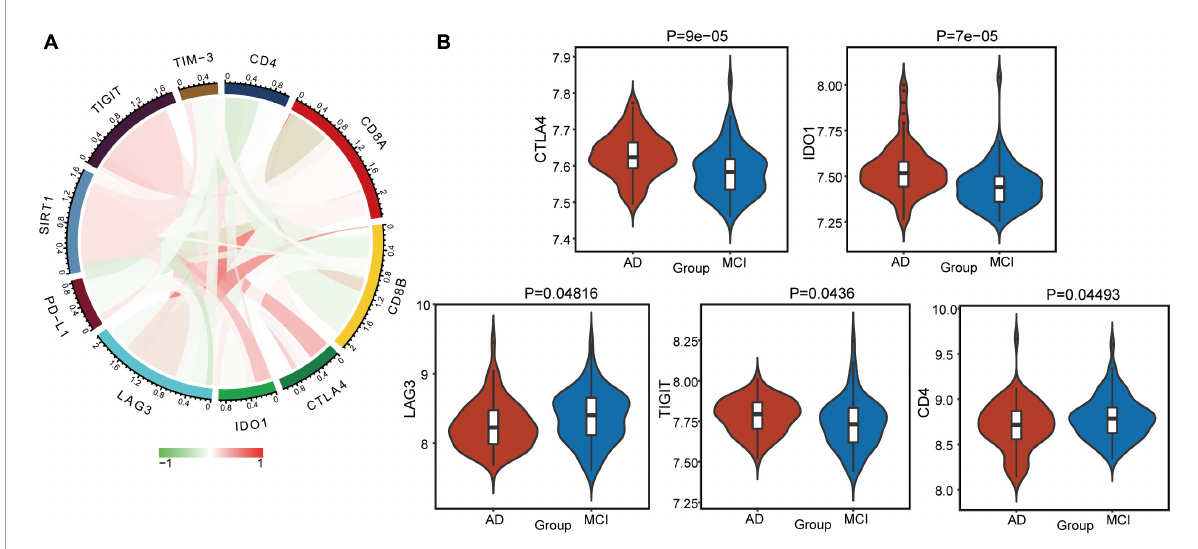
FIGURE7 Alterations in immune checkpoints in AD. (A) Correlations between immune checkpoints and SIRT1. Red indicates positive correlation, and green indicates negative correlation. (B) Differentially expressed checkpoints between AD and